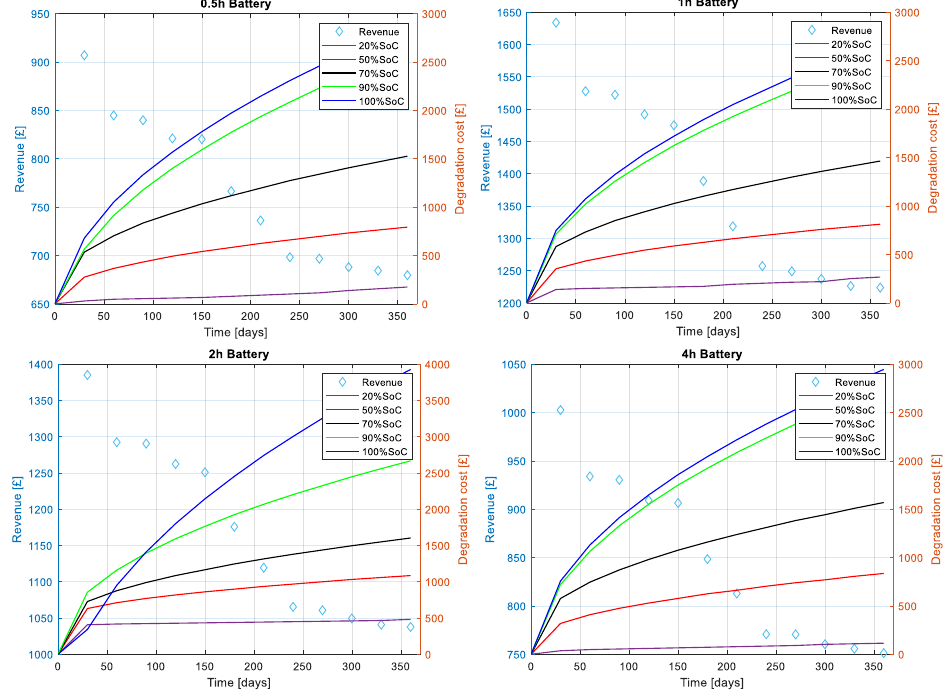
Figure 11. Revenue and degradation cost for 0.5h - 4 h batteries at several SoCs at T = 25 °C. * means a penalty is applicable on this battery at this time. Capacity fade is predicated by Formula (22).